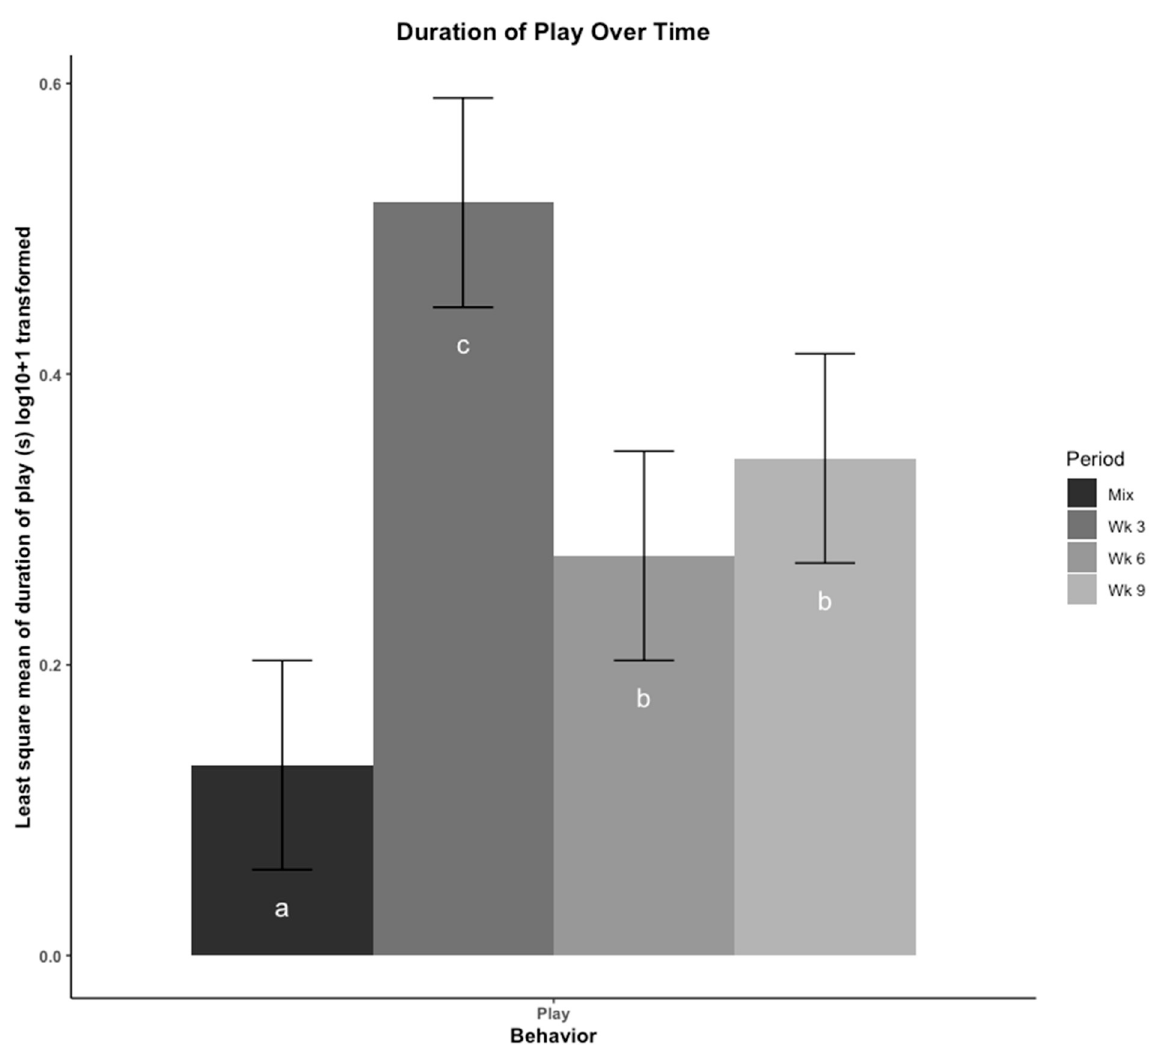
Figure 4. Play was compared across four time points using least square means regression analysis. Play was recorded in duration (seconds (s)) and log 10 + 1 transformed. The four time points are: immediately after mix, and 3, 6, 9 weeks (wk) after mix. Observations at 6 wk were made after pigs were moved to a new pen with their group. Play is presented as total duration (s). Errors bars represent the 95% confidence interval of the least square means. a–c: Bars with different letters denote time periods that showed different frequencies of play behavior ( p < 0.05, Tukey, HSD adjusted).